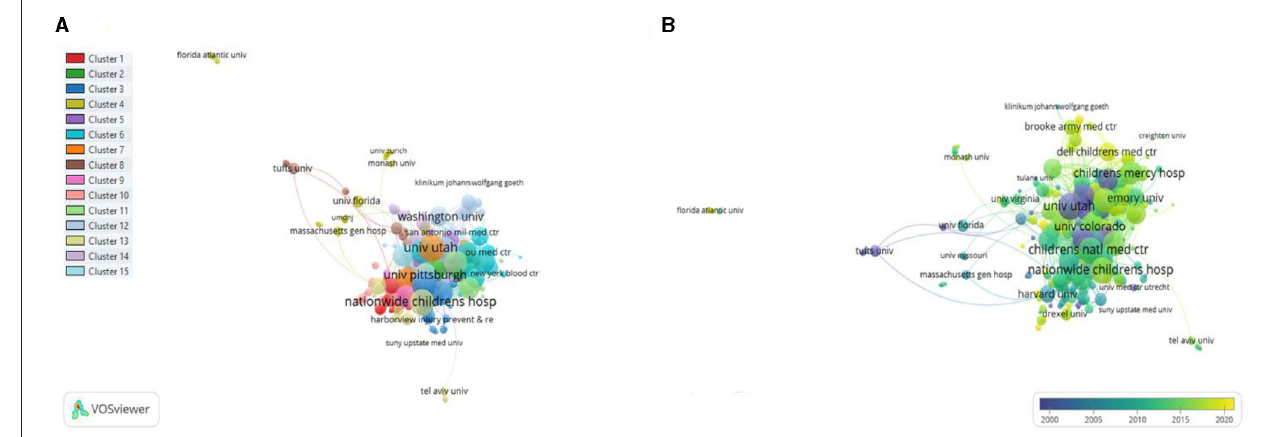
FIGURE 9 | Co-authorship organizations (A) Network visualization. (B) Overlay visualization by time (year).